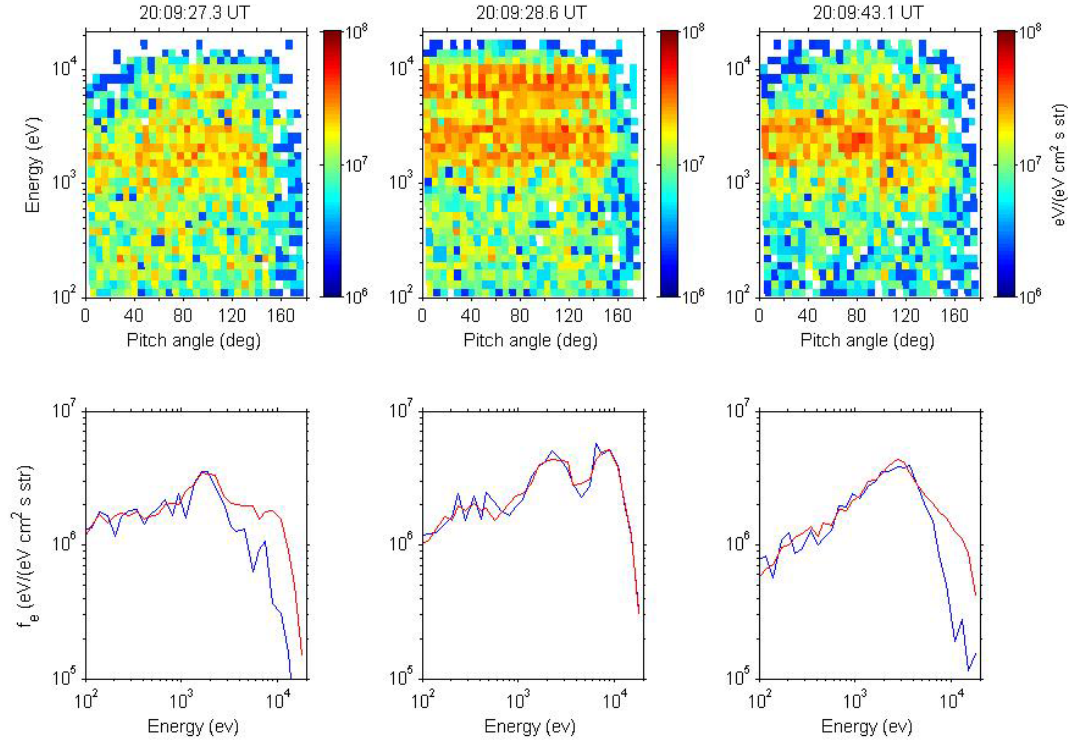
Fig. 8. Top panel: Differential electron energy fluxes as a function of pitch angle and energy. Bottom panel: Downward (blue) and trapped (red) electron energy fluxes as a function of energy. The left column represents a particle distribution between auroral stripes, the middle column a distribution inside a stripe, and the right column a distribution in the region of weak